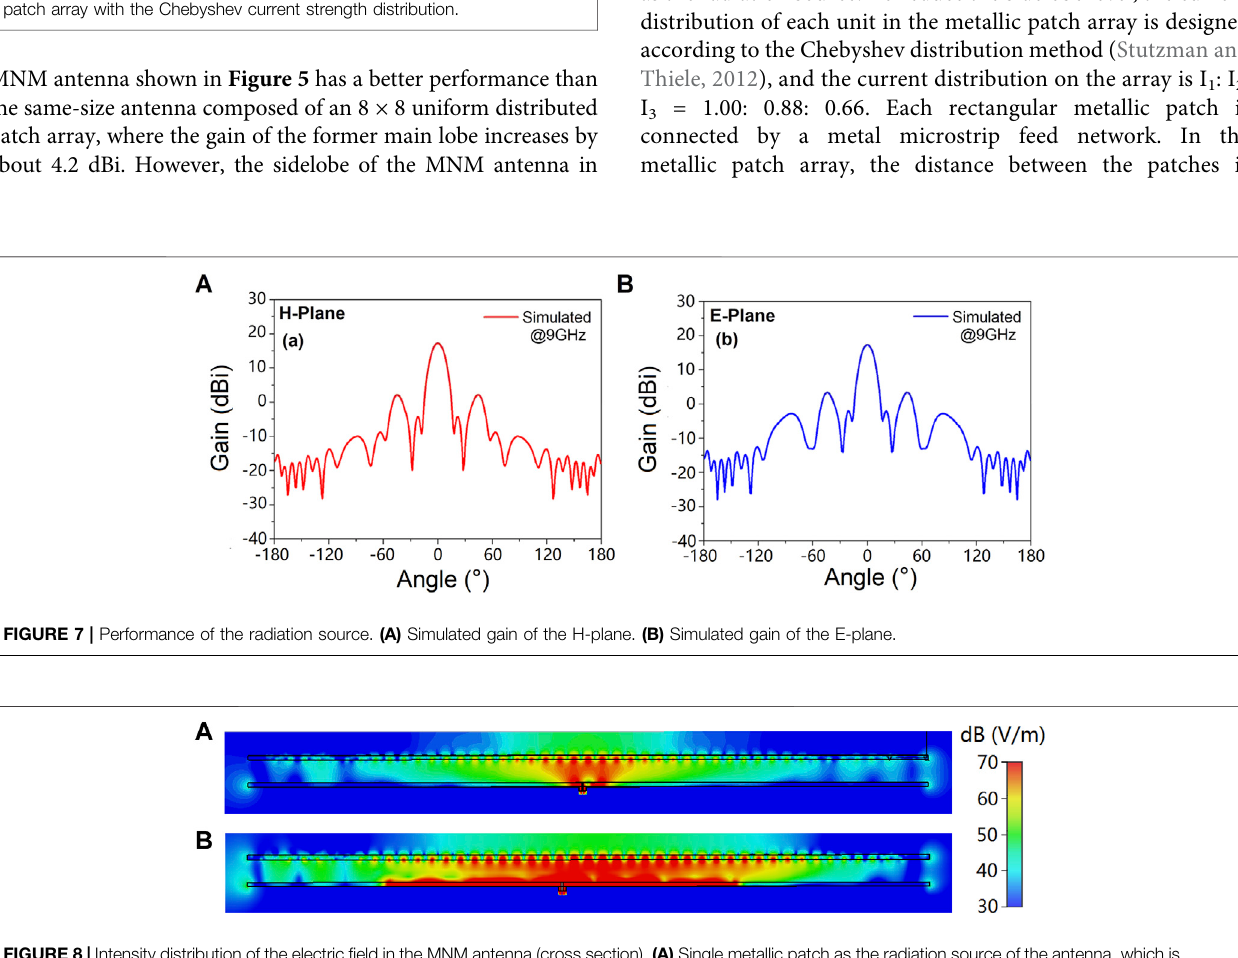
Frontiers in Materials |